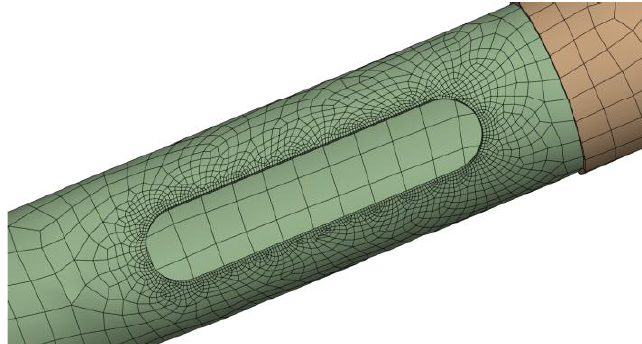
Figure 7. Mesh densification in the area of inspection hole area. Table 4. Configuration and number of fiber layers.